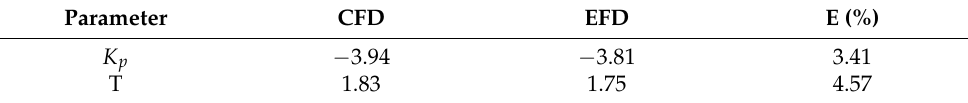
Figure 6. The hydrodynamic derivative of the roll angular velocity K p at different initial heel angles. Table 5. Hydrodynamic parameters related to the roll decay motion.